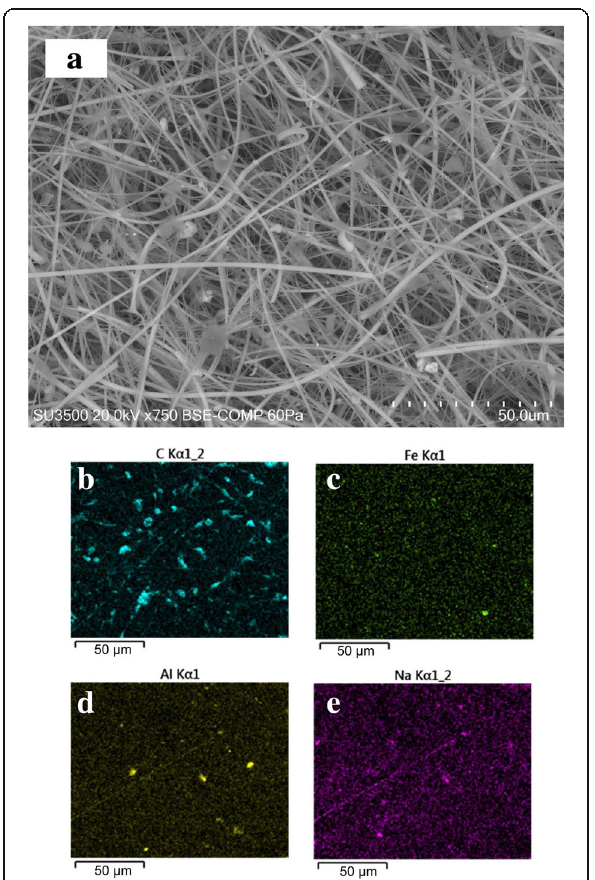
Fig. 10 The SEM image and elemental mapping images of the sample filters obtained at the GD site in July 2015. a The SEM image, ( b ) the elemental map of C, ( c ) the elemental map of Fe, ( d ) the elemental map of Al, and ( e ) the elemental map of Na. The characteristic organic particles commonly exist in the filter